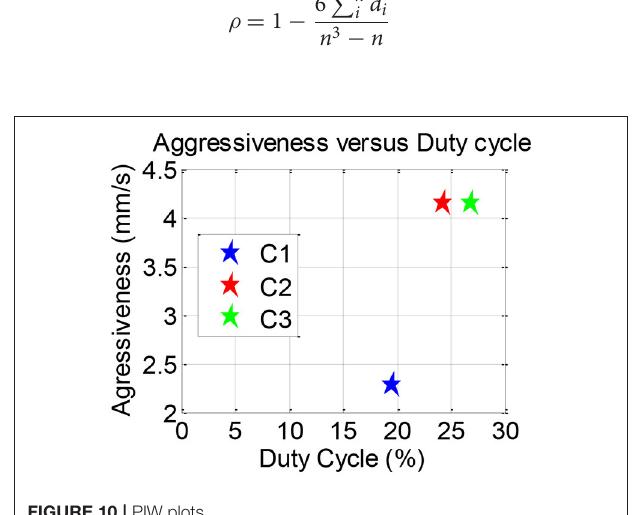
FIGURE 10 | PIW plots.